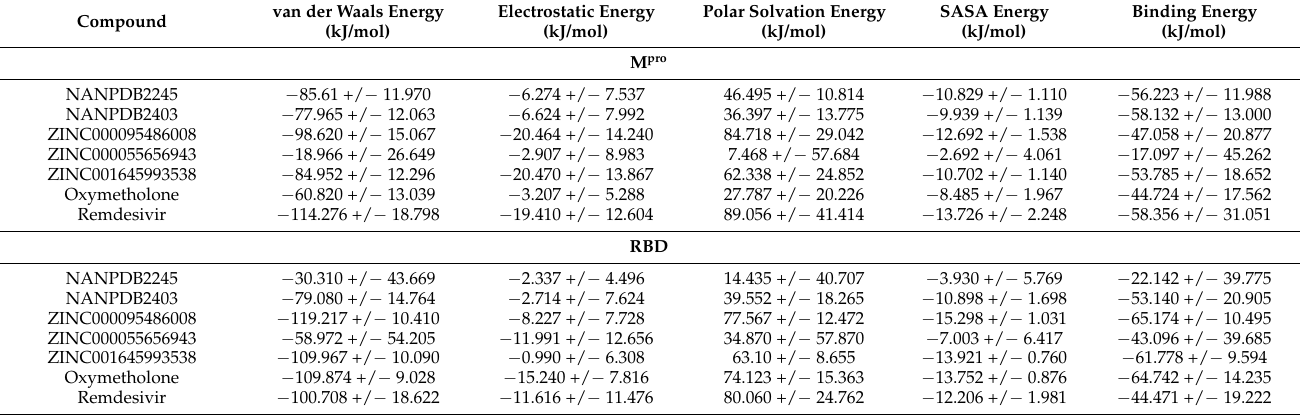
Table 3. Contributing energy terms of the Molecular Mechanics/Poisson-Boltzmann Surface Area (MM/PBSA) computa- tions for receptor–ligand complexes. Values are shown as average ± standard deviations in kJ/mol. The terms consist of van der Waals, electrostatic, polar solvation, solvent-accessible surface area (SASA) and binding energies. Compound van der Waals Energy (kJ/mol) Electrostatic Energy (kJ/mol) Polar Solvation Energy (kJ/mol) SASA Energy